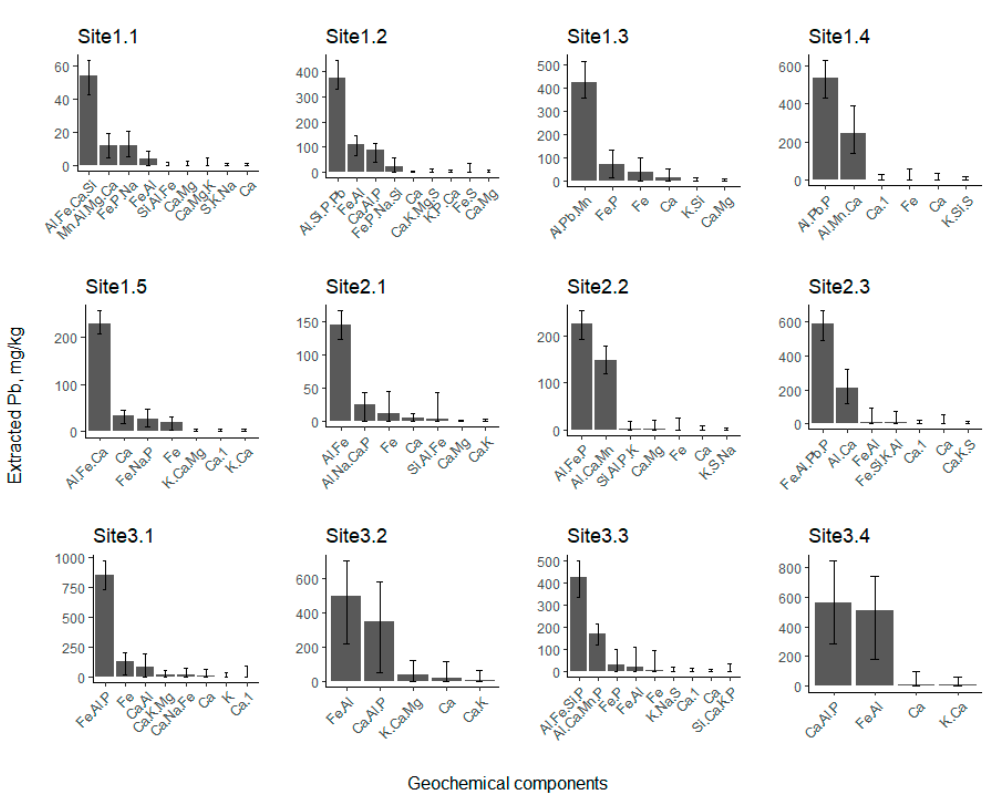
Figure 1. Pb extraction profiles, mg kg − 1.